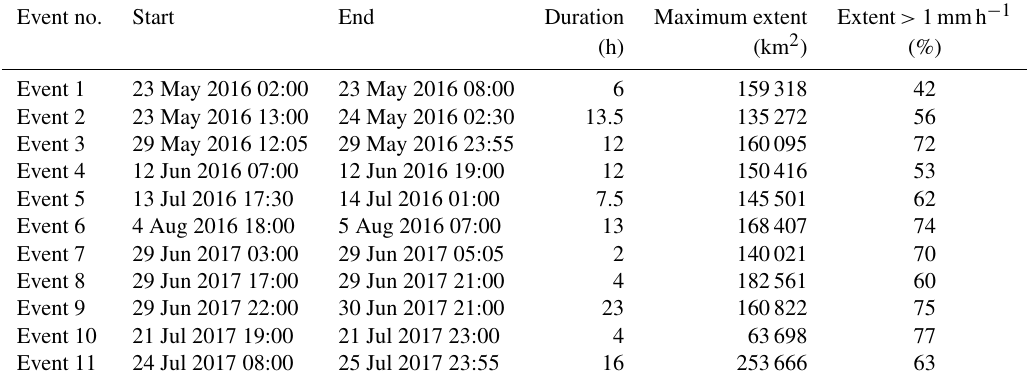
Table 2. Characteristics of the selected